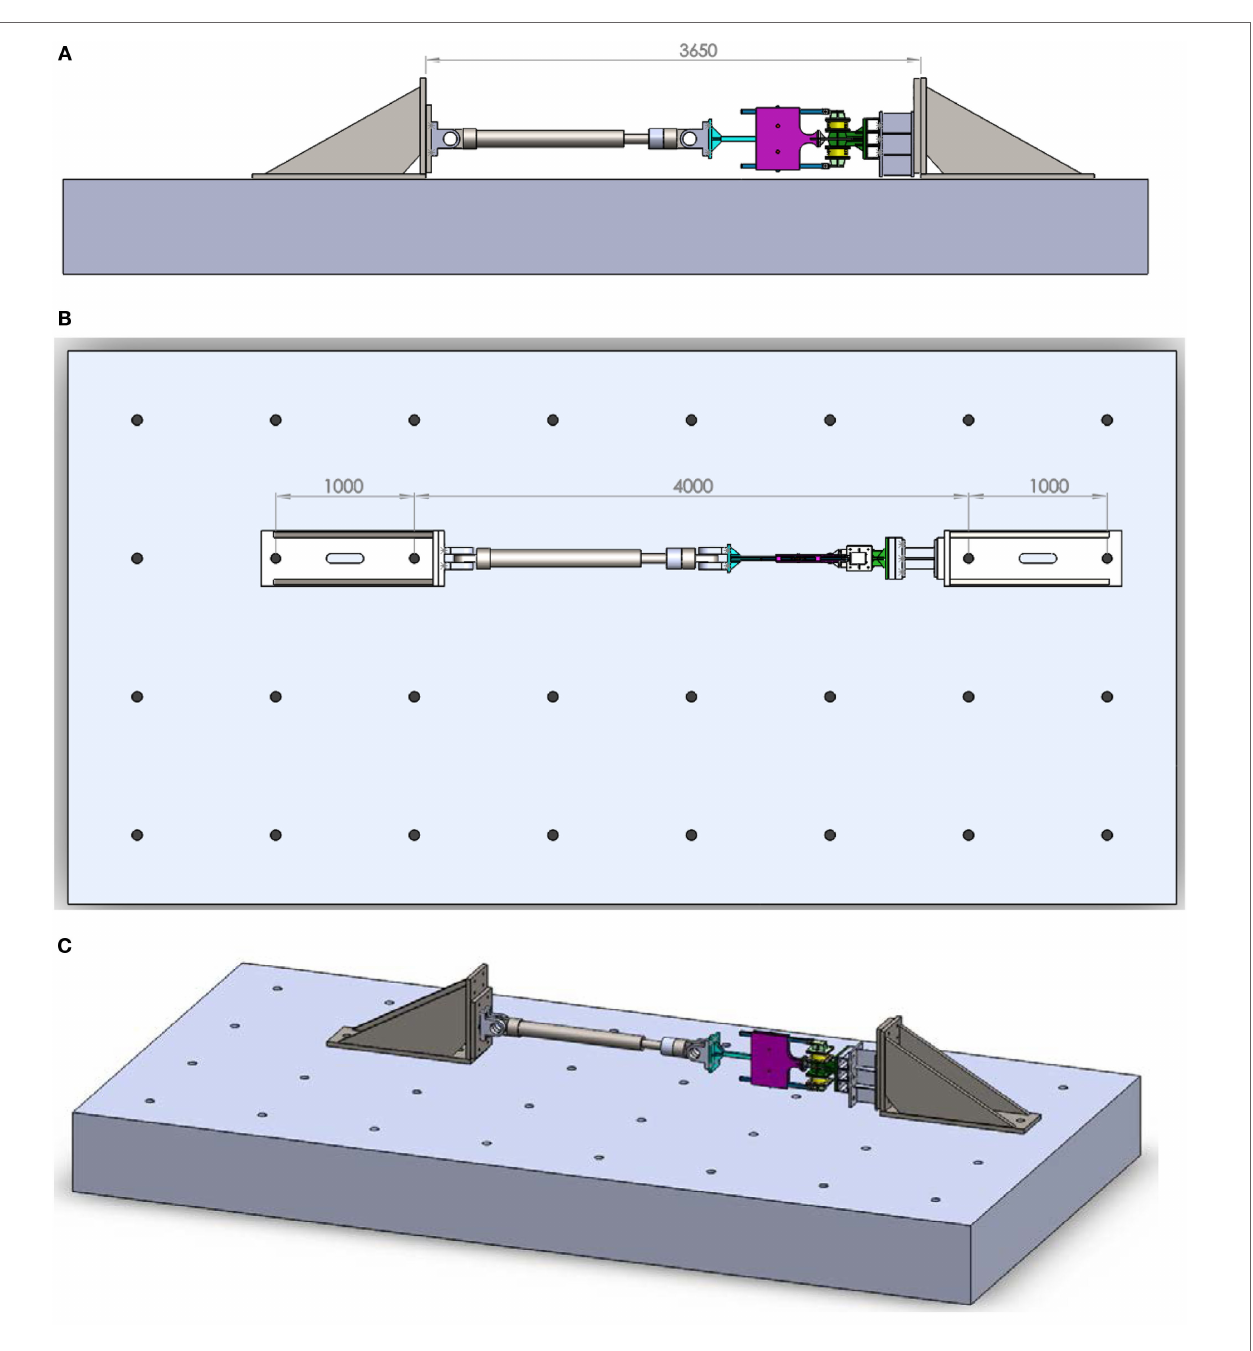
FigUre 3 | Test setup design drawings (a) front view, (B) top view, and (c) 3D